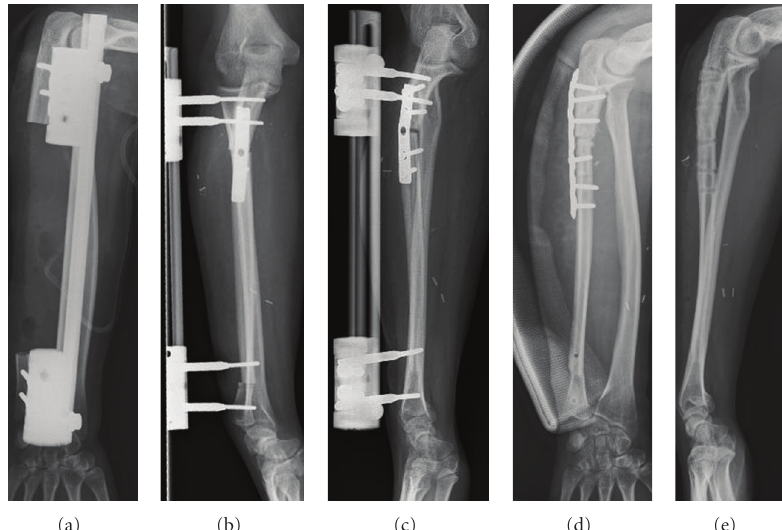
Figure 2: Status after resection of the ulnar diaphysis (patient 1) because of a low grade osteosarcoma (a), and reconstruction with a vascularized fibula graft 3 weeks later (b). A pseudathrosis developed at the proximal junction (c), and it was treated by bone grafting and plate osteosynthesis (d). The final result 2 years after reconstruction